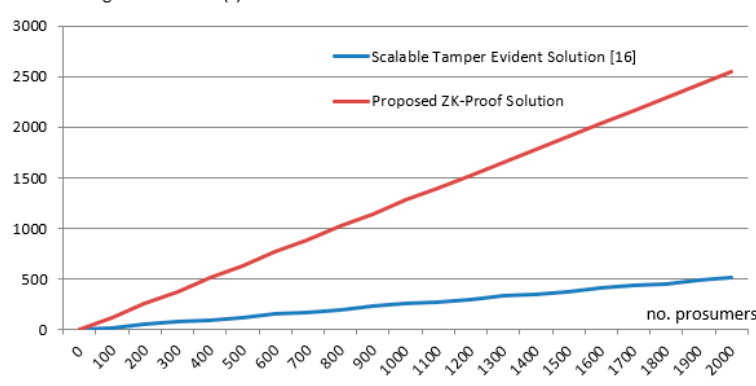
Figure 16. On chain registration time overhead brought by ZKP.